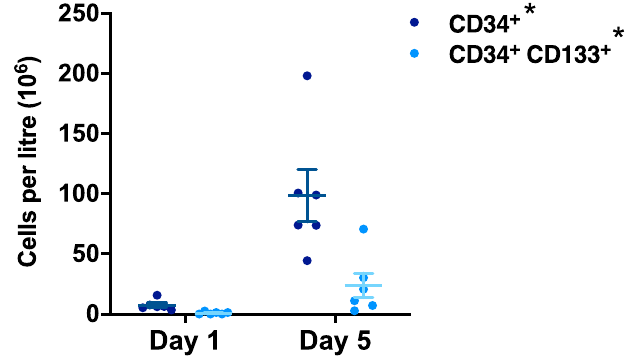
Fig. 2 G-CSF induces mobilisation of HSCs into the peripheral blood. The frequency of circulating CD34 + and CD34 + CD133 + HSCs in the peripheral blood of participants with FA at baseline (day 1) or in response to G-CSF administration (day 5). Statistical comparisons are day 5 vs day 1 (baseline) using the sign test. * P = 0.031 (two-sided). Graph depicts mean ± standard error; n = 6 biologically independent samples. Source data are provided as a Source Data fi le.